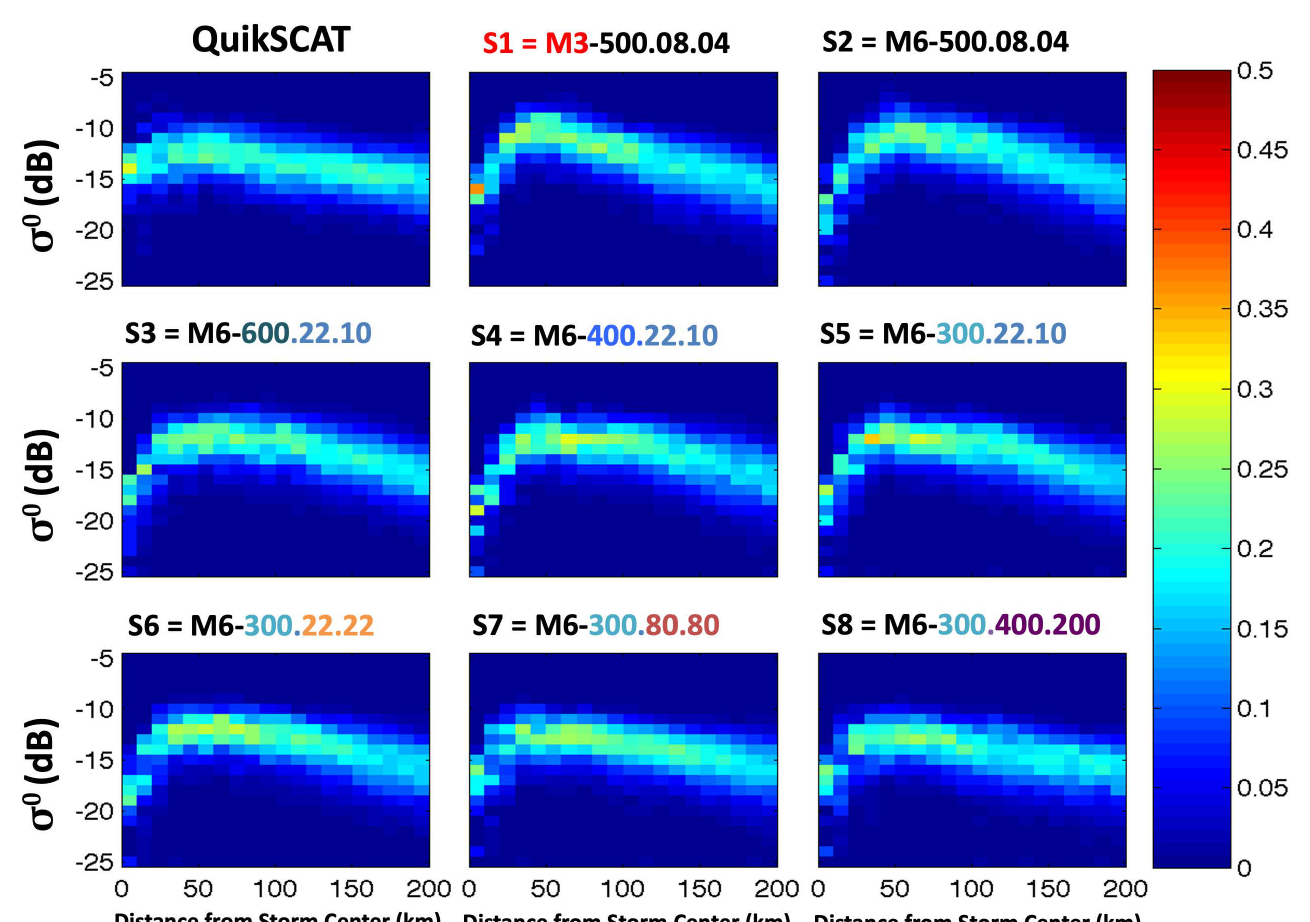
Figure 13. The Probability Density Function (PDF) distribution of the scatterometer signal as function of distance from storm center: Top-left is from the QuikSCAT scatterometer observations; all other panels represent the results from the synthetic observations computed using the geophysical parameters as simulated with the different microphysical choices. The observations, and the eight different experiments, are arranged in the same order as in Figure